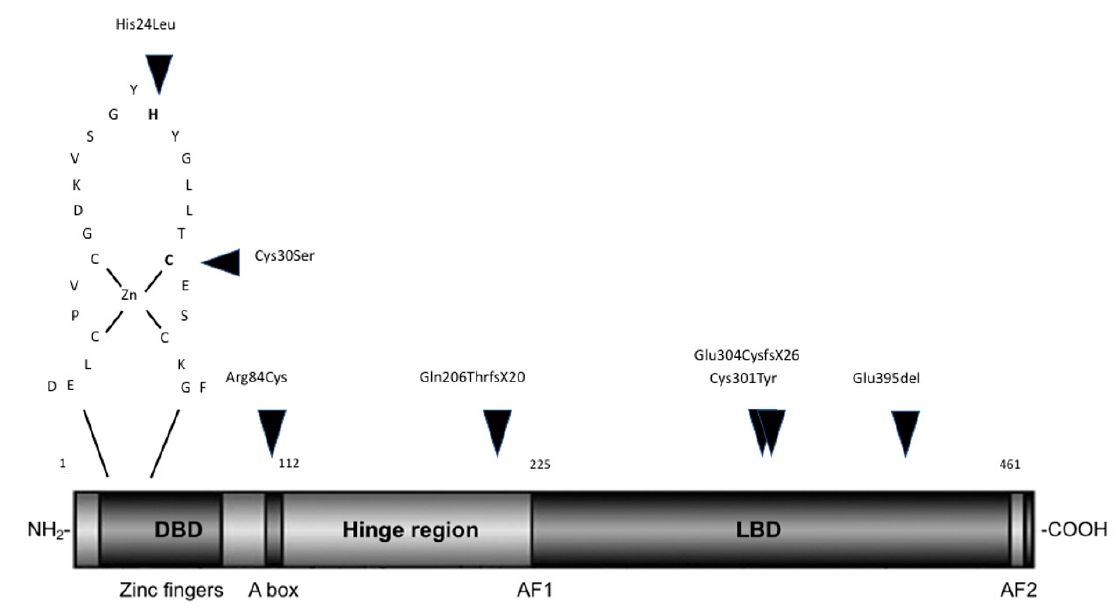
Figure 1. Scheme of the structure of the NR5A1 protein and localization of studied variations. Critical functional domains comprise a DNA-binding domain (DBD) at the amino terminal (from amino acids 13 to 112) containing two zinc finger domains (ZNI and ZNII) and an A box, the flexible hinge region (amino acids 112–225) and a ligand-binding domain (LBD) (amino acids 225–458) with activation function 1 (AF1) and 2 (AF2). A close-up loop of the first zinc finger domain in DBD is shown where the His24Leu and Cys30Ser alterations are located. Locations of the NR5A1 variations described in this work are indicated by arrow heads.